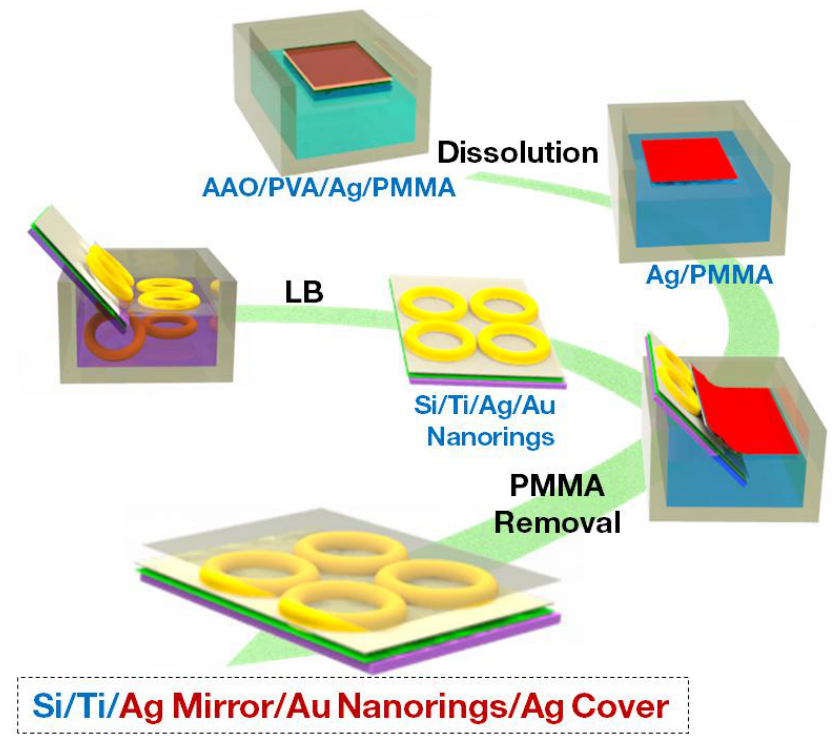
Figure 1. Flow chart of fabrication process of Ag mirror / Au nanorings / Ag cover sandwich nanofilm. The mirror refers to substrate underlying the layer of Au nanorings, and the cover represents top layer on Au nanorings. LB denotes Langmuir-Blodgett technique.